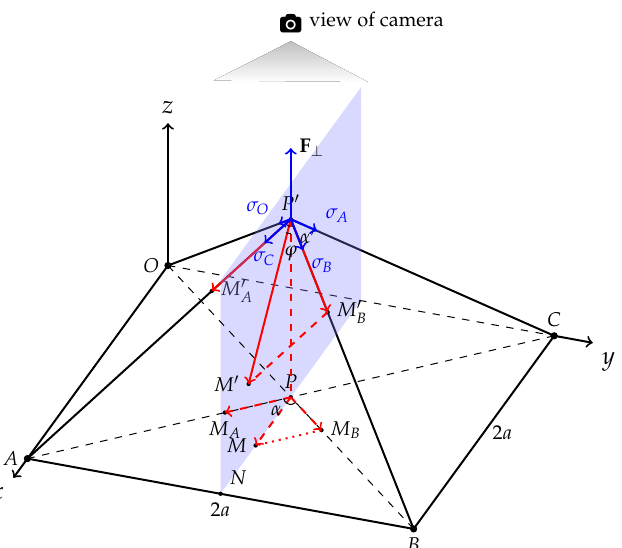
Figure 4. Deformation of the PDMS film as a linear elastic material with normal external force applied. OABC is a square PDMS film, with a side length of 2 a , fixed on the x – y plane at its four corners— O , A , B , and C . At its center P , F ⊥ is applied perpendicularly to the x – y plane, moving P to P (cid:48) and deforming the film with a press depth of d (= PP (cid:48) ) . The four components of F ⊥ on the OP (cid:48) , AP (cid:48) , BP (cid:48) , and CP (cid:48) axes are, respectively, σ O , σ A , σ B , and σ C . M is an arbitrary point other than P , moving to M (cid:48) after deformation. The angle between P (cid:48) M (cid:48) and PP (cid:48) is denoted by ϕ . N is the intersection point −−→ −−→ −→ PM A and PM B , with angle α , are two components of PM . The of PM , extended to side AB .